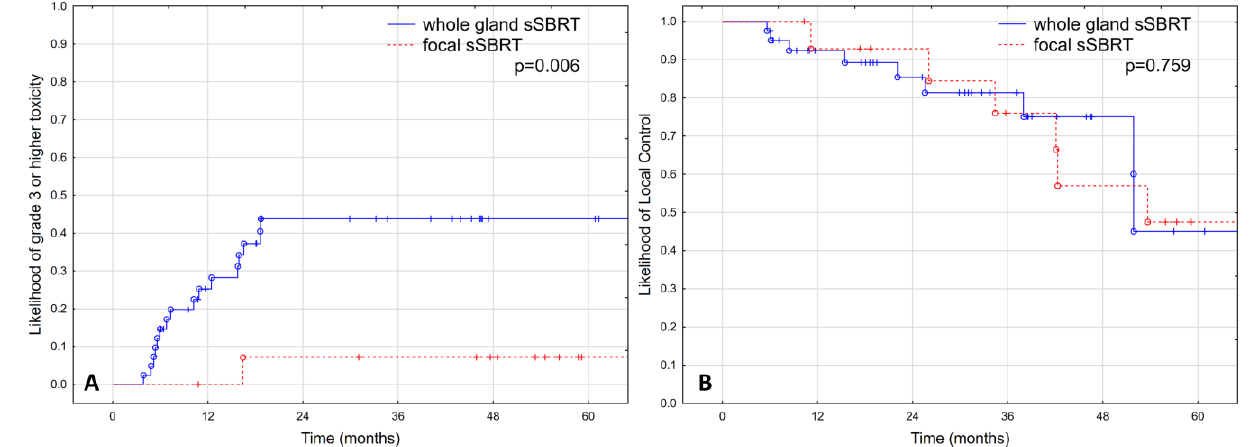
Figure 1. Rate of grade ≥ 3 adverse events ( A ) and local control ( B ) depending on the extent of irradiation in 56 patients treated with hypofractionated salvage re-irradiation for local post-radiotherapy prostate cancer recurrence.